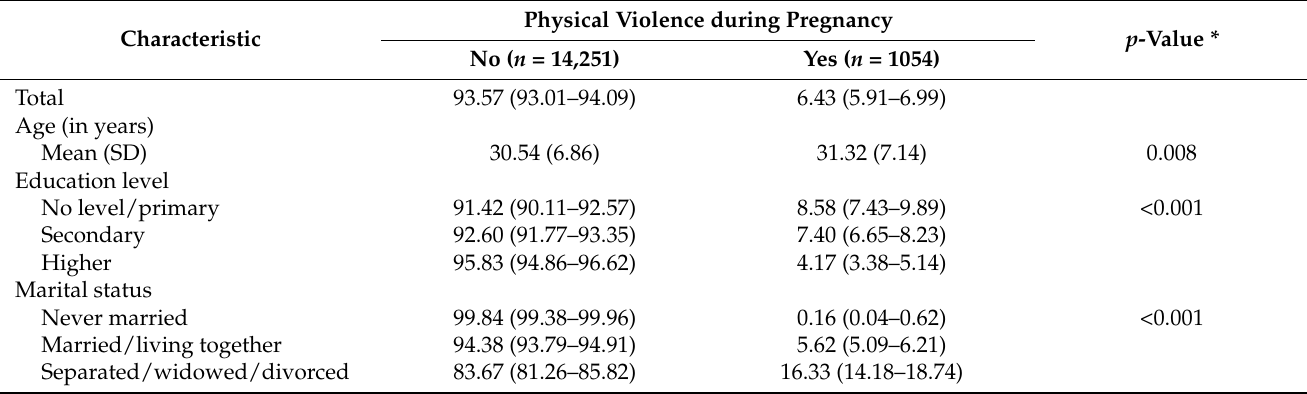
Table 2. Characteristics of women aged 15 to 49 years according to whether they experienced physical violence during pregnancy, ENDES